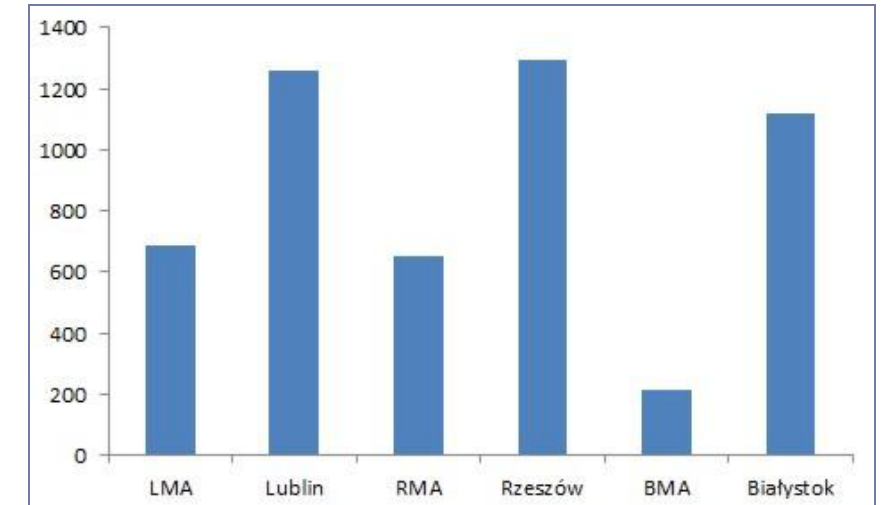
Fig. 6. Entities entered in the business registry REGON per 10 thousand inhabitants